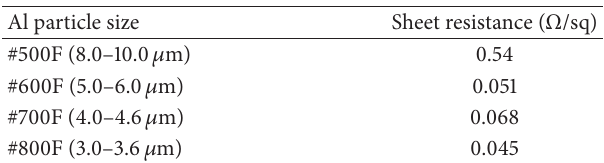
Table 1: Dependence of sheet resistance on the size of Al particles in “ Paste 1.